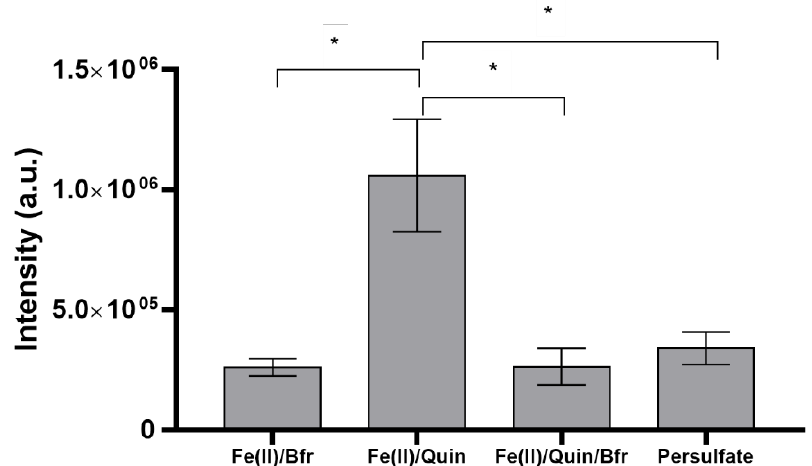
Figure 2. Number of hydroxyl radicals, measured as DMPO–OH signal intensity (a.u. arbitrary units) and produced with the four radical-generating systems. Fe(II)/Bfr: Fe(II)-phosphate buffer; Fe(II)/Quin: Fe(II)-quinolinic acid; Fe(II)/Quin/Bfr: Fe(II)-quinolinic acid-phosphate buffer; Persulfate: thermal degradation of peroxydisulfate. Bars marked by asterisks differ significantly by Tukey’s test ( p ≤ 0.05 * ).